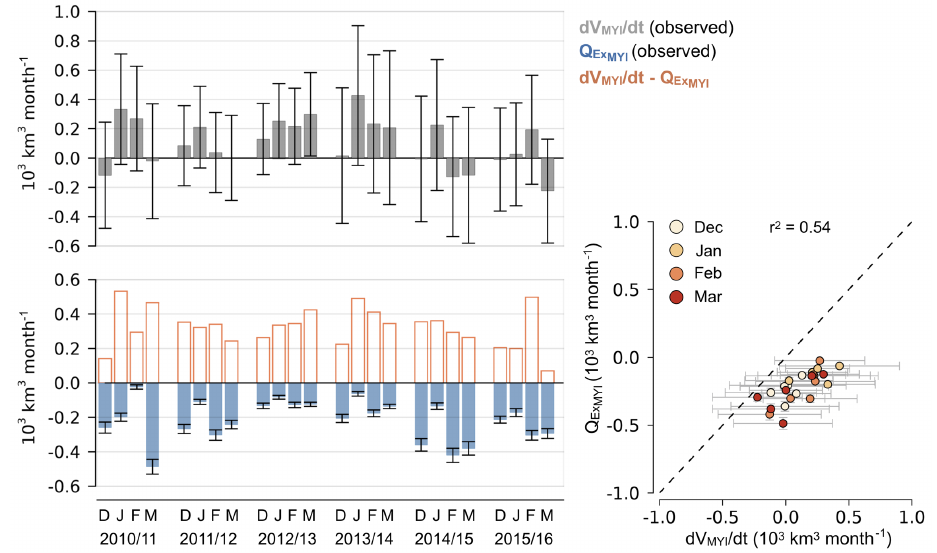
Figure 9. Monthly MYI volume export through the Fram Strait ( Q Ex between December and March for the winter seasons 2010–2011 and 2015–2016. Error bars represent the corresponding uncertainties. The scattergram shows the relation between d V MYI / d t and Q Ex